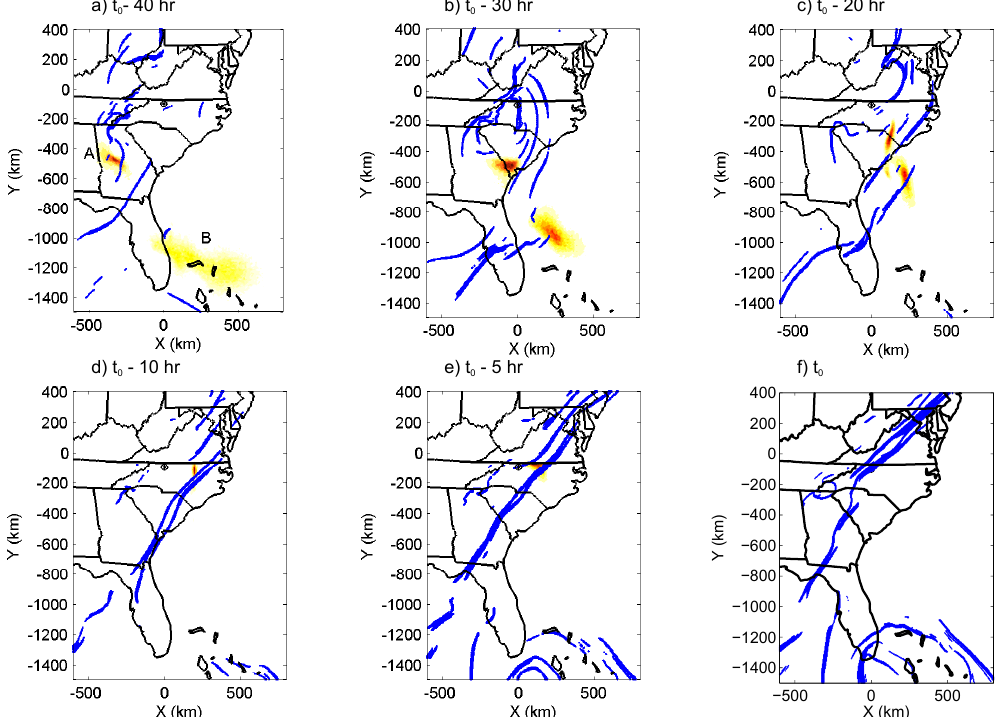
Figure 15. Sequence of the hyperbolic LCSs (blue) and two probabilistic source regions corresponding to two successive samples. Proba- bilistic regions “A” and “B” (a) correspond to the virtually red and blue particles in Fig. 12. These six panels correspond to 40, 30, 20, 10, 5 and 0h before collecting the corresponding samples at 13:40 and 14:00UTC during the interrogation window (see the Supplement